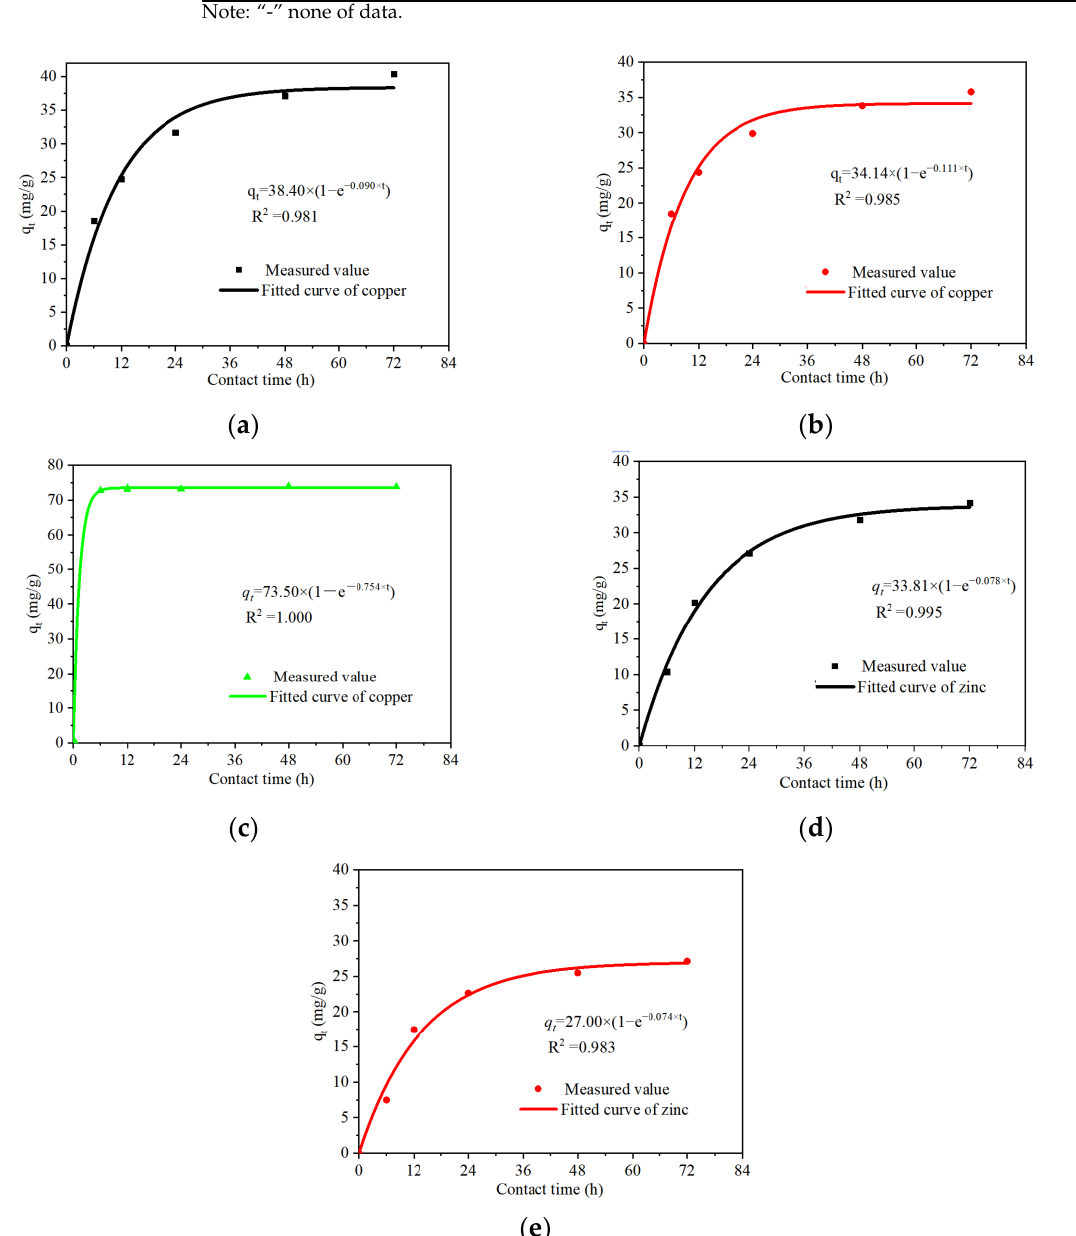
Figure 3. The pseudo-first-order kinetic models of HMs adsorption, Cu 2+ : ( a ) HAP, ( b ) CP, ( c ) PAS; Zn 2+ : ( d ) HAP, ( e ) CP.